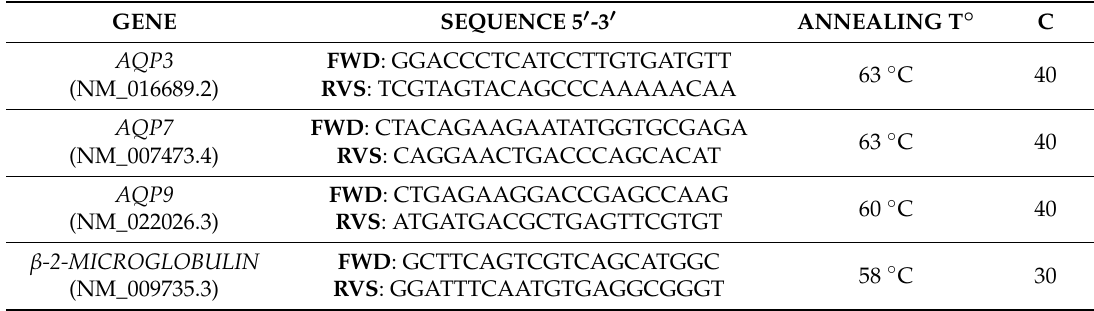
Table 1. Oligonucleotides and cycling conditions for PCR amplification of Aquaporin-3 ( Aqp3